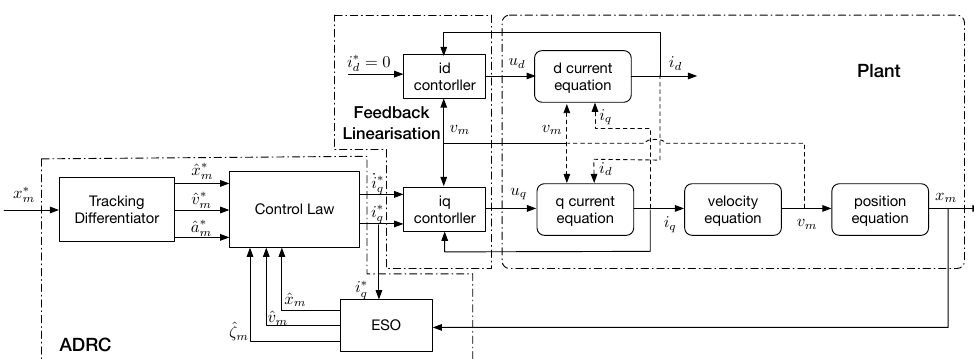
Figure 2. Block diagram of the proposed tracking controller and